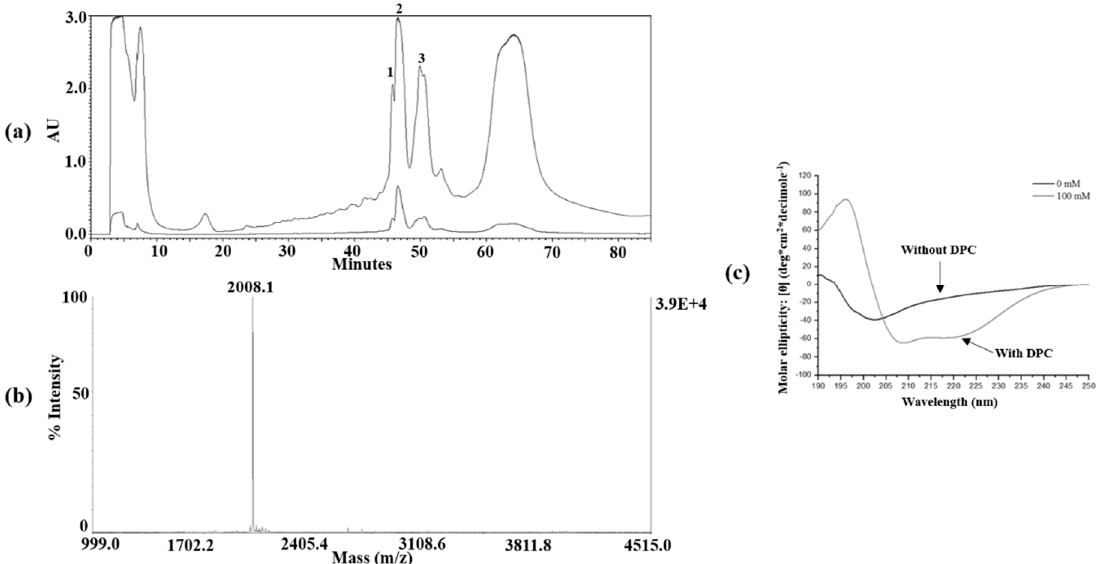
Figure 2. ( a ) HPLC chromatogram of YK5 and 12% Tris − tricine PAGE using reverse phase − C18 column. The band shown in lane 2 of 12% Tris − tricine PAGE is YK5. ( b ) MALDI − TOF mass spectrum of YK5. The spectrum was measured in positive ion reflector mode. ( c ) CD spectrum of YK5 showing a difference in secondary structure with or without dodecylphosphocholine (DPC) micelles.